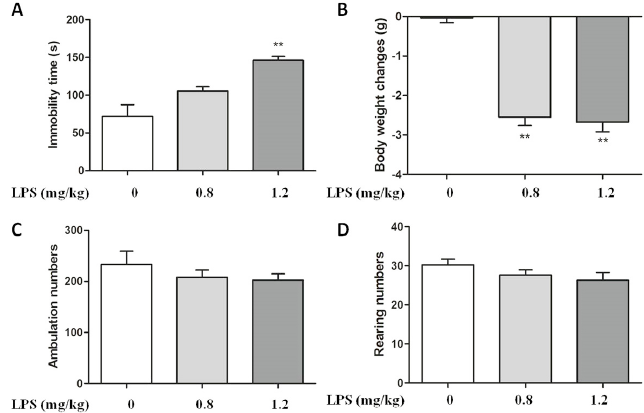
Figure 1. LPS induced depressive-like behavior in C57BL/6 mice. Mice were injected i.p. with 0.8 mg/kg or 1.2 mg/kg LPS, 24 h after LPS injection, immobility time in the forced swimming test ( A ), body weight ( B ), the numbers of ambulation in the open field test ( C ), and the numbers of rearing in the open field test ( D ) were measured. Data are expressed as the mean ± SEM, ** p < 0.01 compared with control group ( n = 8 per group).